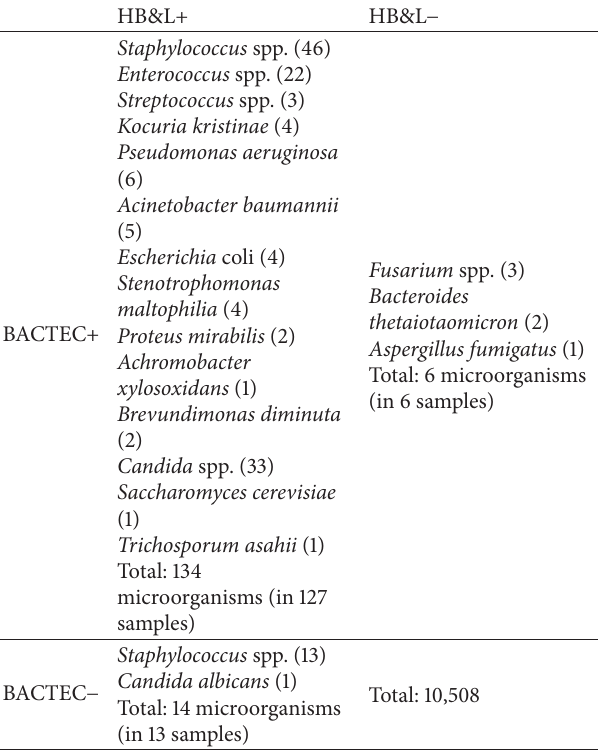
Table 1: Isolated pathogens in comparative study between BACTEC and HB&L